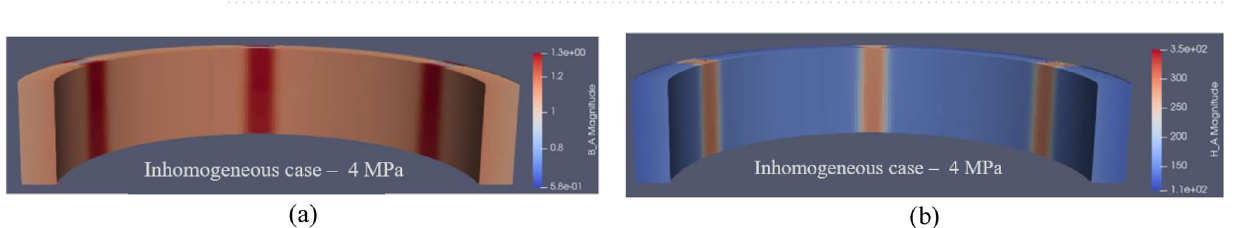
Figure 29. Magnetic flux density ( a ), magnetic field ( b ) Code_Carmel - Inhomogeneous 1 MPa ( B average = 1.1 T).